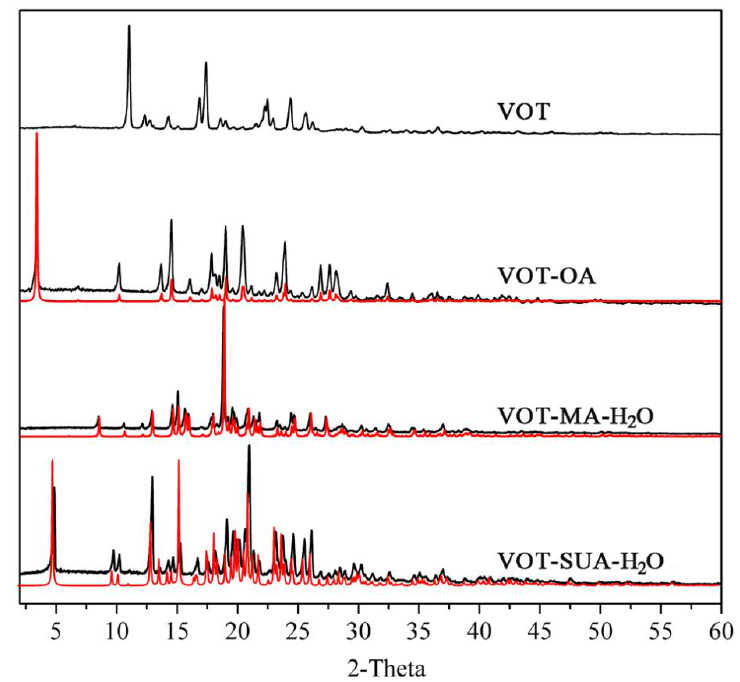
Figure 6. Experimental (black) and simulated (red) powder X-ray diffraction patterns for VOT, VOT-OA, VOT-MA-H 2 O, and VOT-SUA-H 2 O salt.